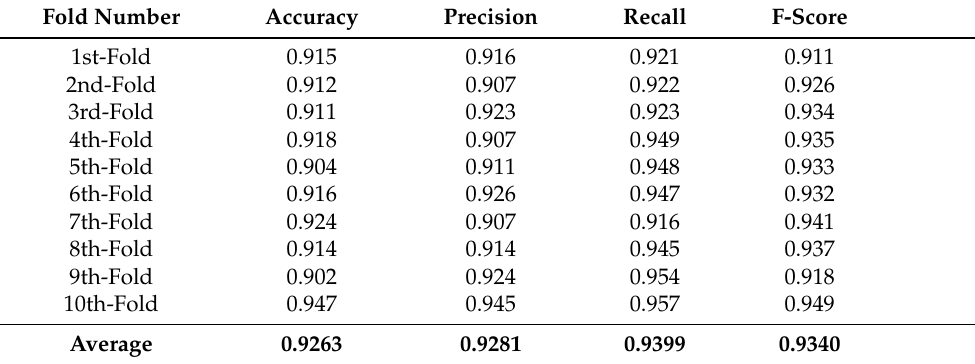
Table 9. Ten fold cross-validation results using CNN deep